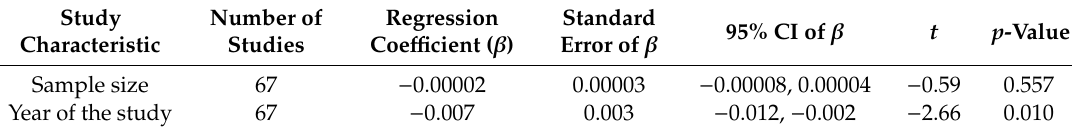
Table 3. Individual variable (univariable) meta-regression model for each study